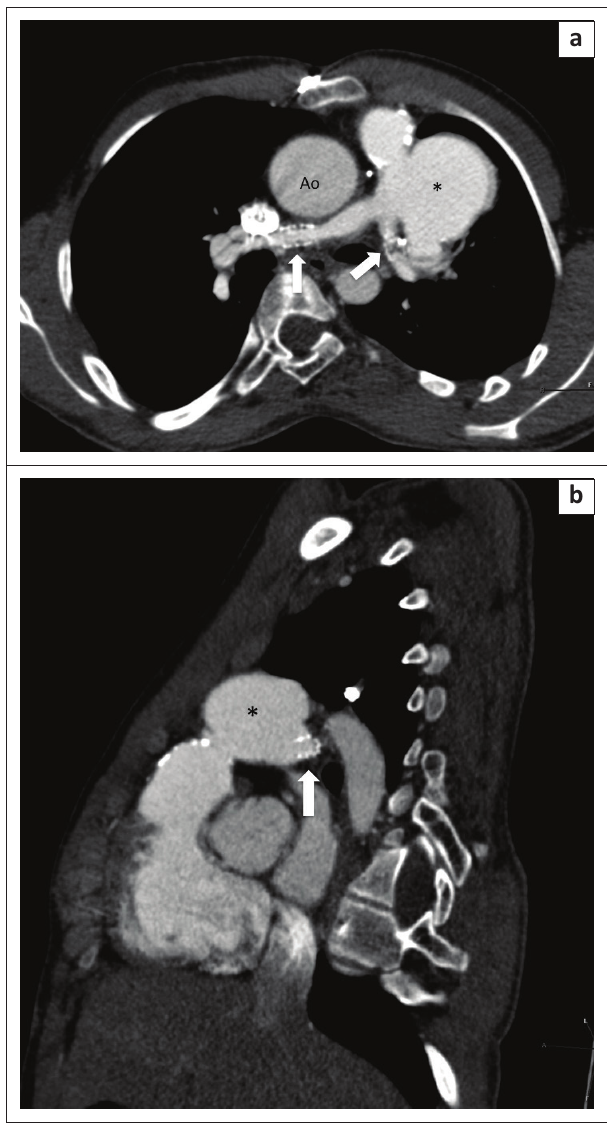
FIGURE 13: Contrasted CTA in a 15-year-old patient with a large aneurysm of the refashioned RVOT (asterisk). Axial MIP (a) and sagittal MIP (b): Note metallic stents within both right and left main pulmonary arteries